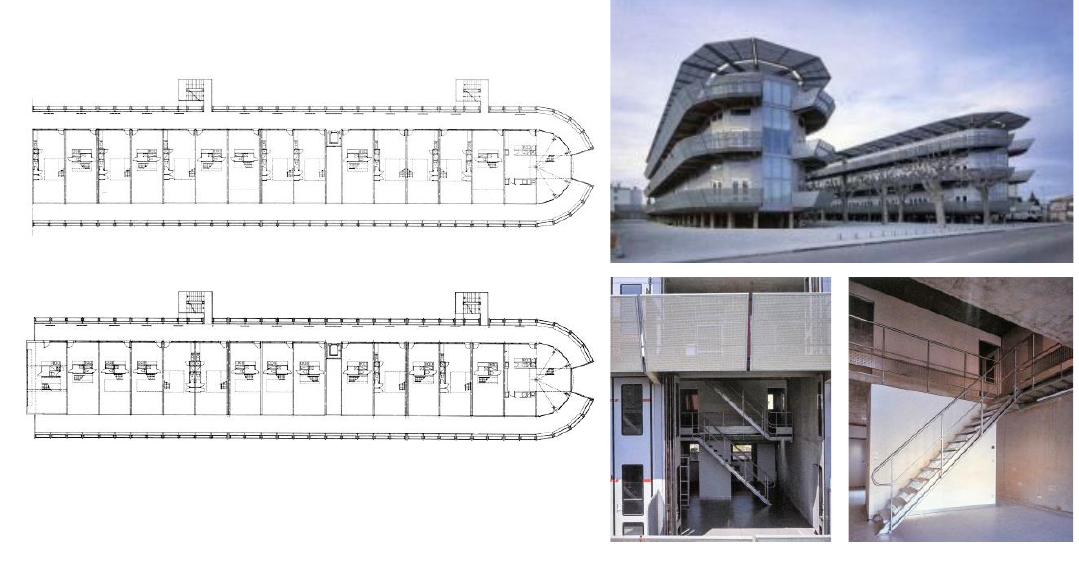
Figure 5 Nemausus settlement, J. Nouvel, 1987,